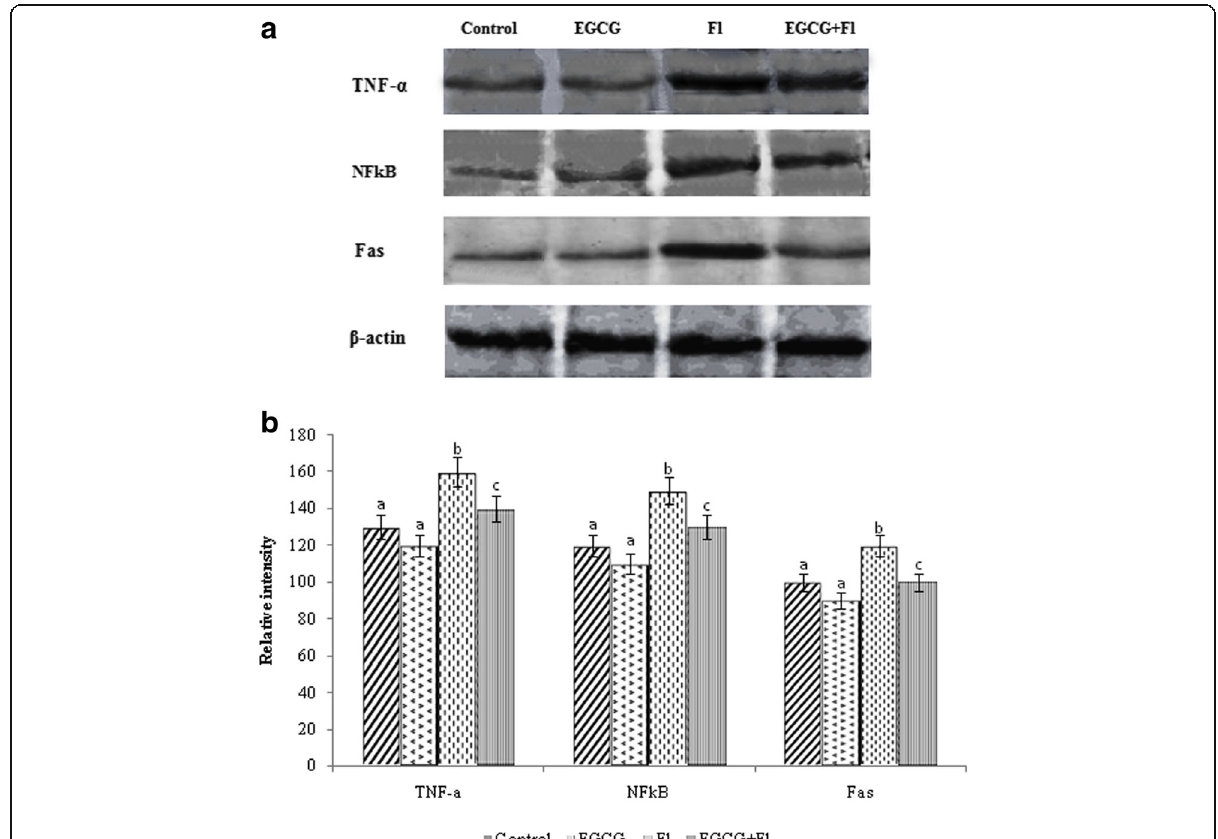
Fig. 9 a Effect of EGCG on TNF-a, NF-kB and Fas protein band intensity expression through western blot analysis in the hippocampus of control and experimental rats. b The densitometric analysis of protein expression of TNF-a, NF-kB and Fas of hippocampus of control and experimental rats. Values are mean ±SD for six rats in each group. a, b and c Values are not sharing a common superscript letter (a, b and c) differ significantly at p < 0.05